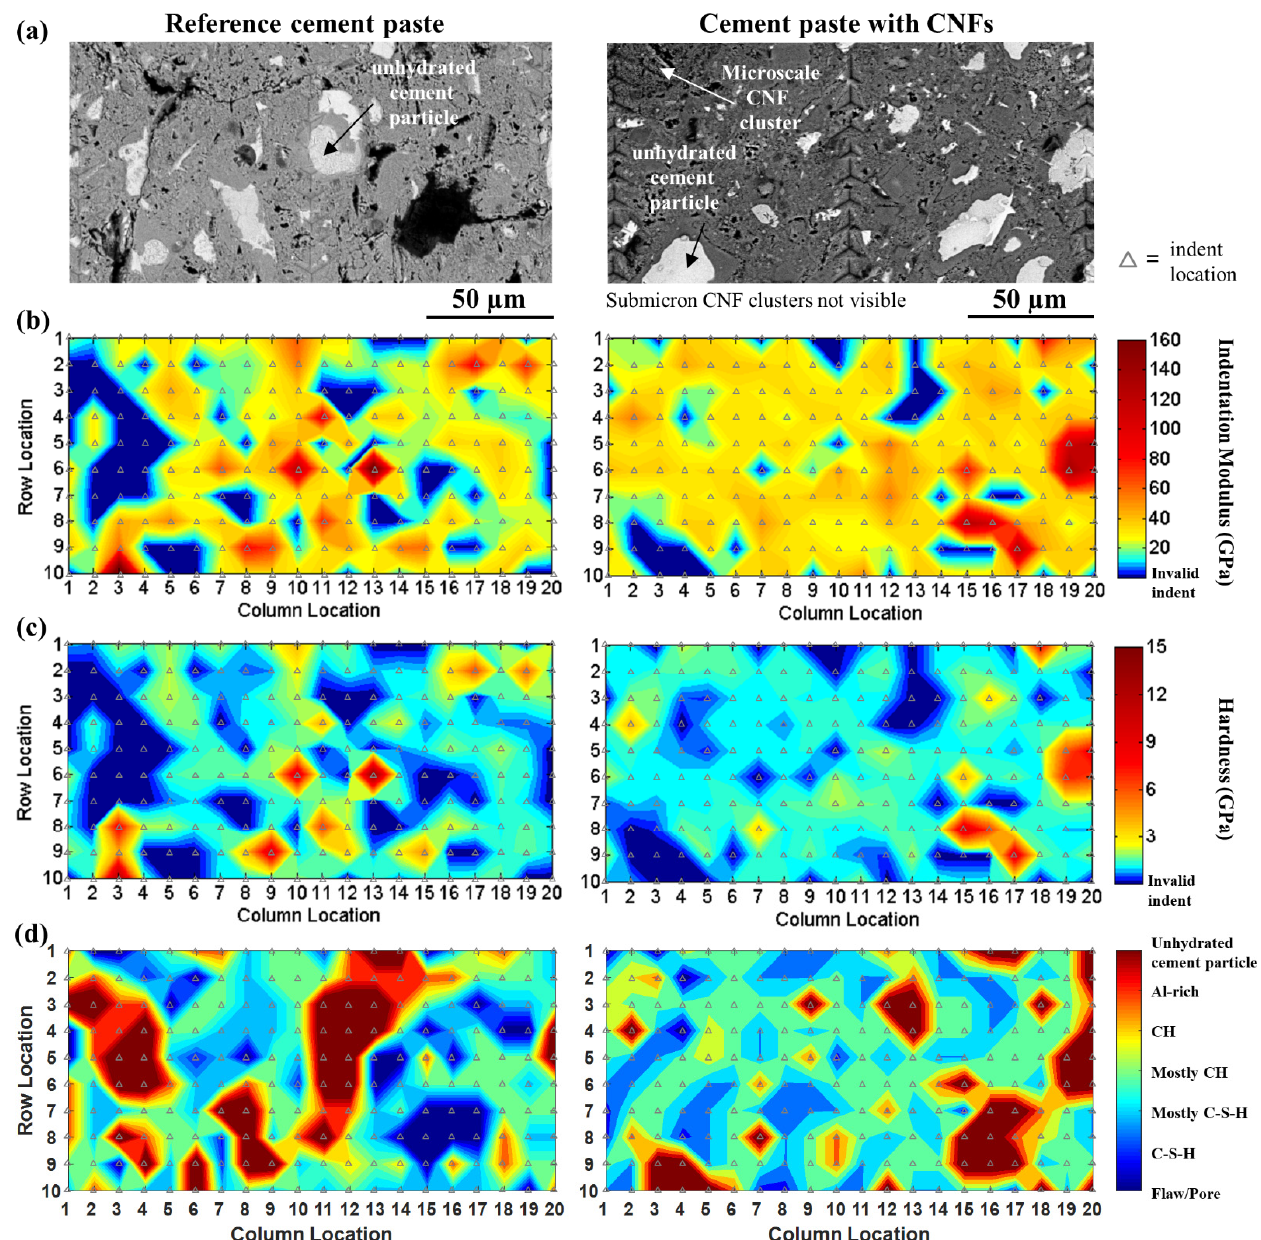
Figure 7. ( a ) SEM backscattered electron (BSE) image of a representative nanoindentation grid and corresponding ( b ) indentation modulus, ( c ) hardness, and ( d ) chemical phase contour maps for the reference cement paste ( left ) and the cement paste with CNFs ( right ).